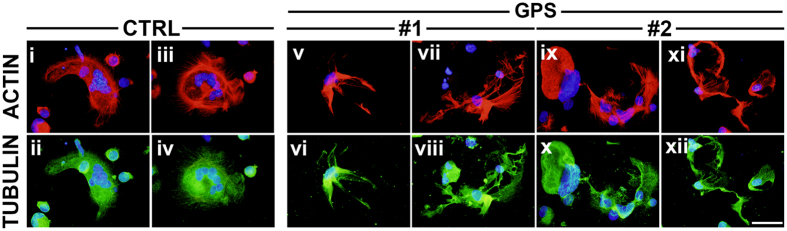
Anomalous cytoskeleton contractility of GPS megakaryocytes upon adhesion on type I collagen.Control (CTRL)- (i–iv) and GPS-derived megakaryocytes (v–xii) at the end of differentiation were plated on type I collagen-coated cover-slips, at 37 °C in a 5% CO2 atmosphere. After 16 hours adherent cells were fixed and stained for immunofluorescence analysis of the cytoskeleton components actin (red = TRTIC-phalloidin) and tubulin (green = α-tubulin). Nuclei were counterstained with Hoechst 33258 in blue (scale bar = 20 μm).